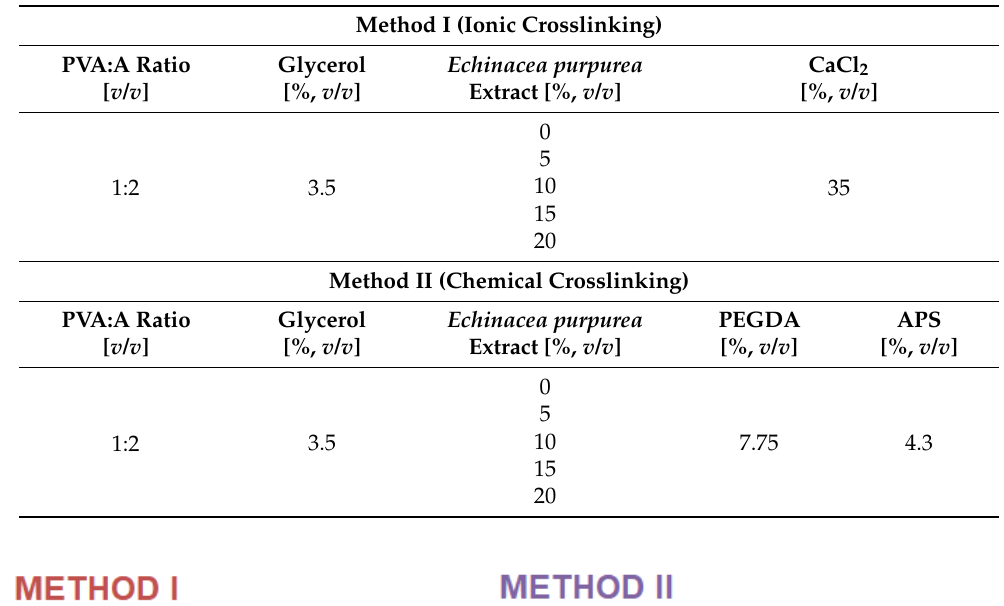
Table 1. Compositions of SA/PVA/ EP hydrogels.